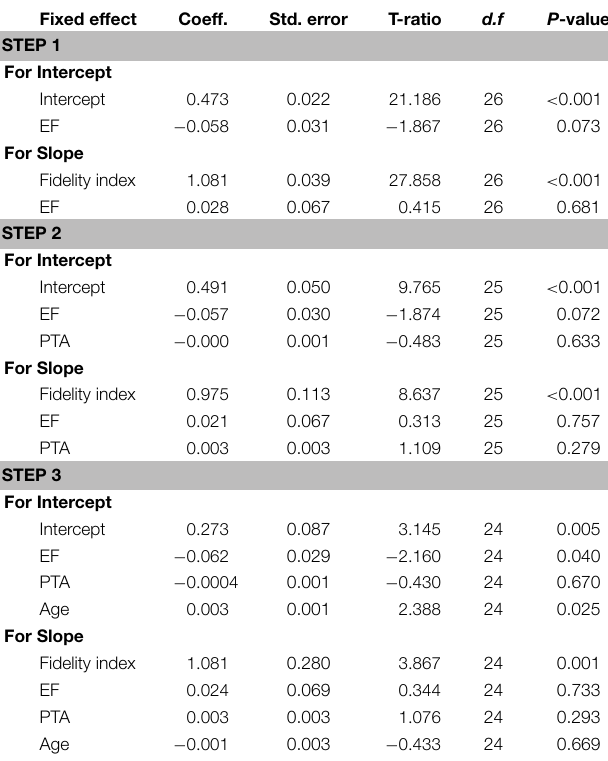
TABLE 6 | Summary of hierarchical linear model for quality with executive function (EF) as a predictor. Fixed effect